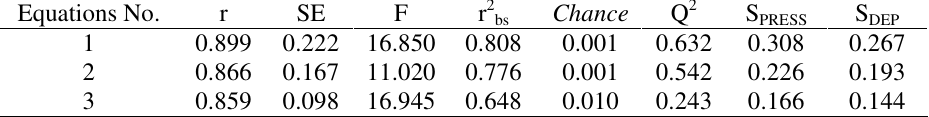
Table 3. QSAR statistics of significant equations Equations No.